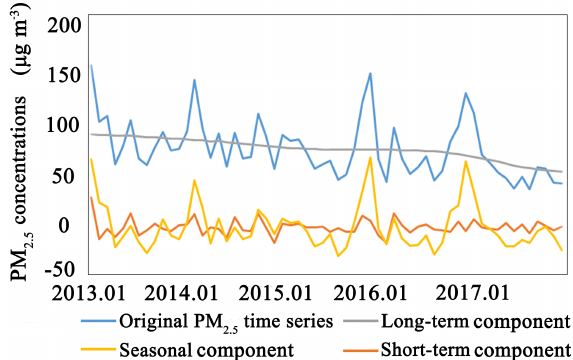
Figure 2. The long-term, seasonal and short-term components ex- tracted from the original time series of mean urban PM 2 . 5 concen- trations in Beijing from 2013 to